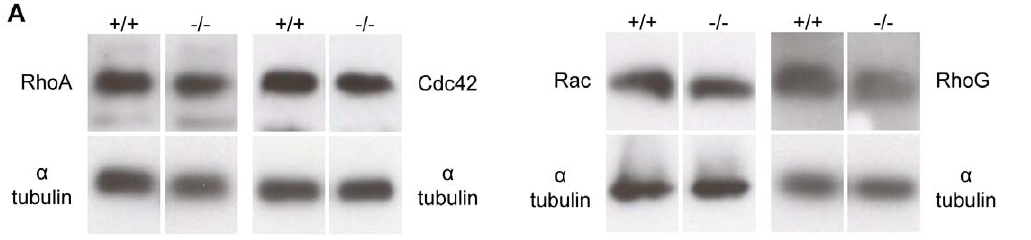
Figure 6. Expression of other small GTPase proteins is normal in RhoF 2 / 2 mice. ( A ) Analysis of expression of the small GTPases Rac, RhoA, Cdc42 and RhoG in platelets from RhoF 2 / 2 mice. a -tubulin was used as a loading